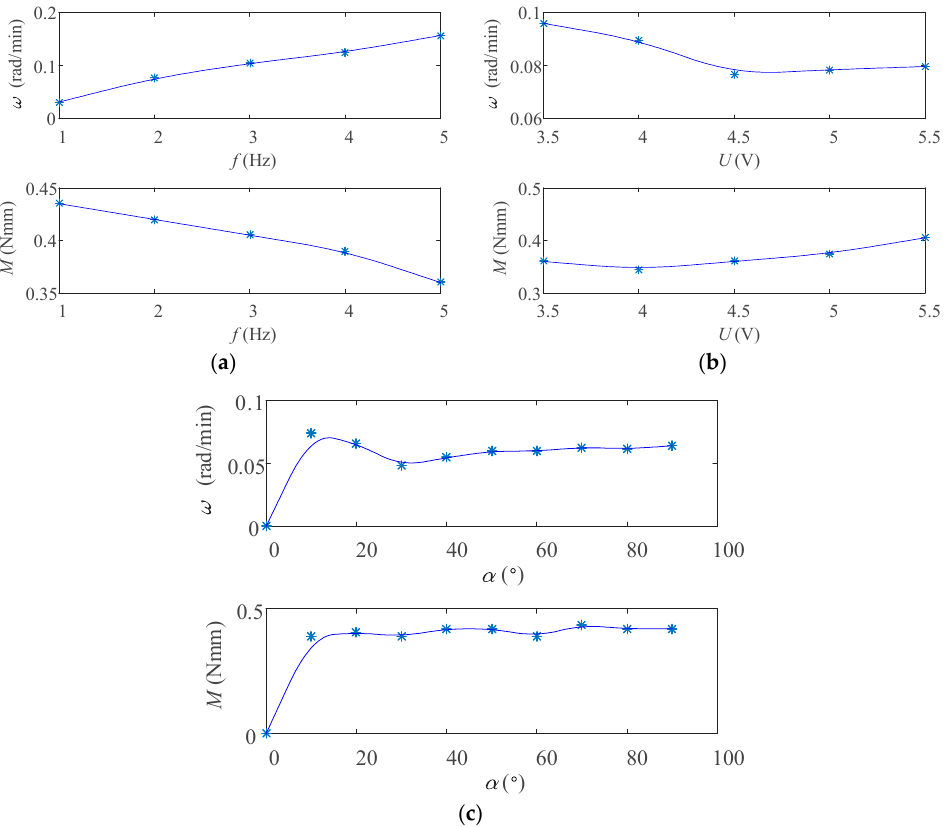
Figure 19. The law of the speed and torque of the prototype with different drive parameters. ( a ) Change with the driving frequency; ( b ) change with the electromagnetic drive voltage; ( c ) change with the phase difference α of the two drive signals.